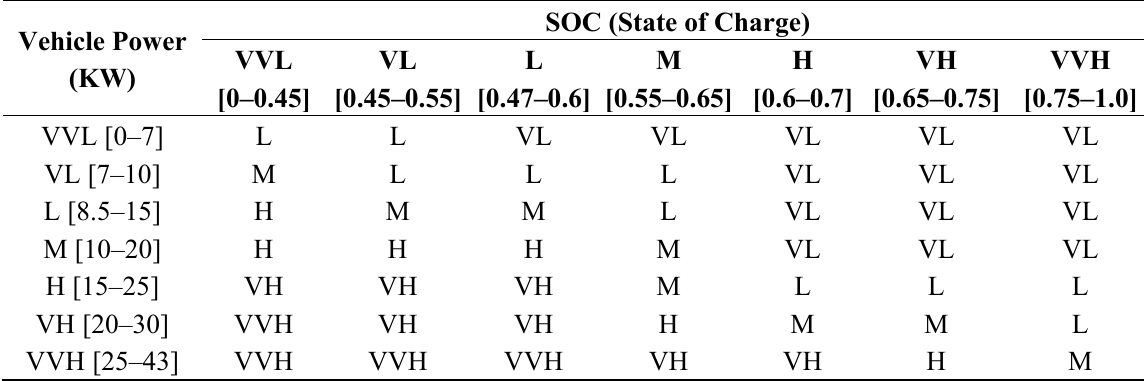
Table 2. Rule base of the ICE fuzzy logic controller.